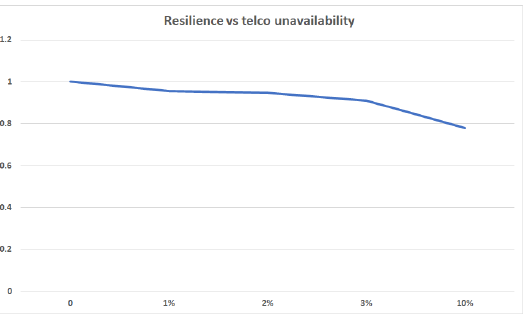
Figure 17. Resilience vs. telecommunication network/SCADA problems. Table 5. Parameters used for S4 ( low SCADA system availability )